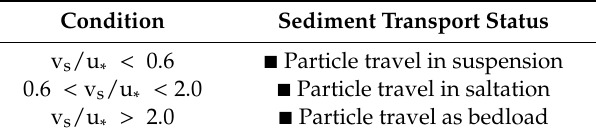
Table 2. Flow conditions and sediment transport status